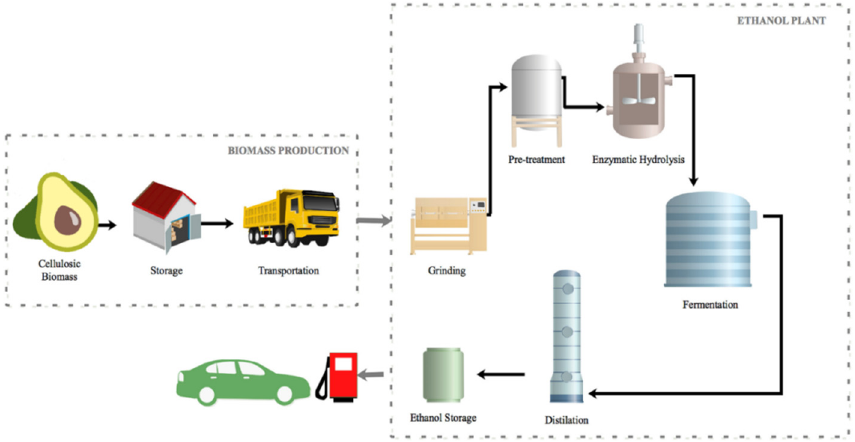
Figure 3. Bioethanol production from avocado’s cellulosic biomass. Reprinted with permission from Karagoz P et al. Lignocellulosic ethanol production: Evaluation of new approaches, cell immobilization and reactor configurations. Renewable Energy . Copyright (2019) Elsevier